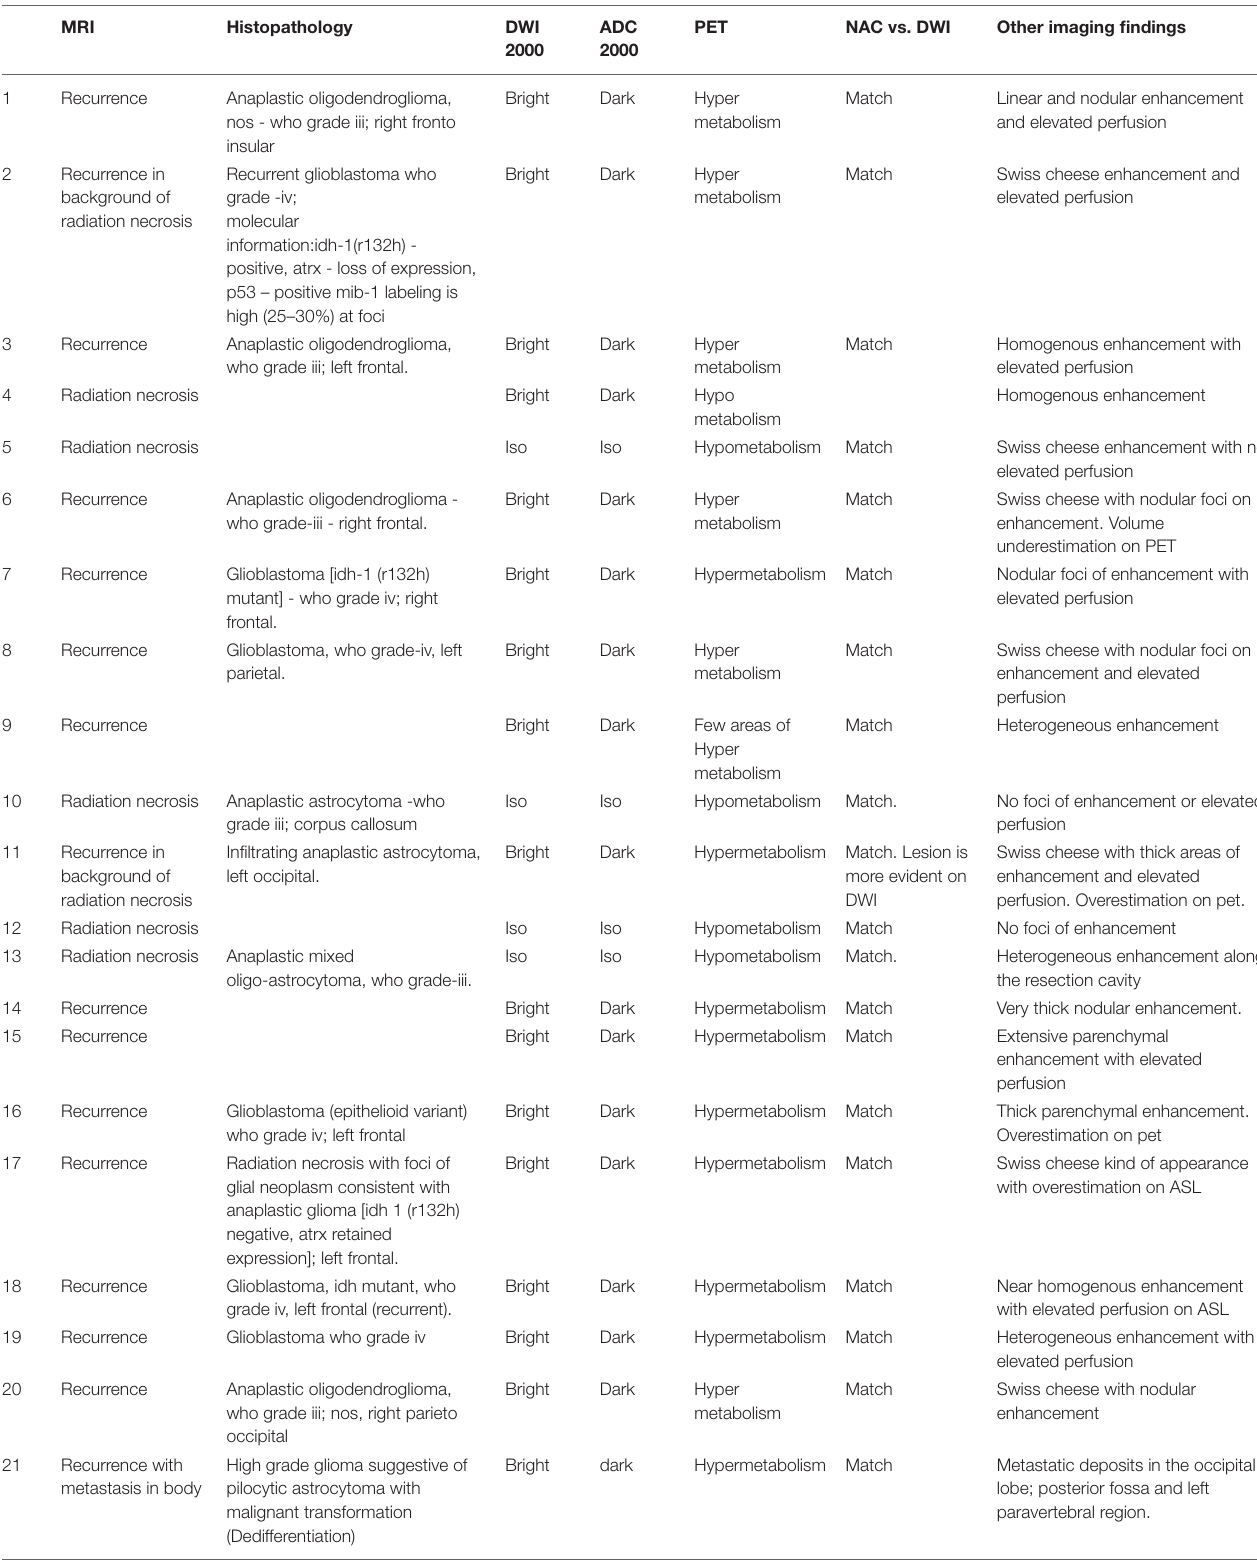
TABLE 1 | Brief summary of GLIOMA cases evaluated with MRI